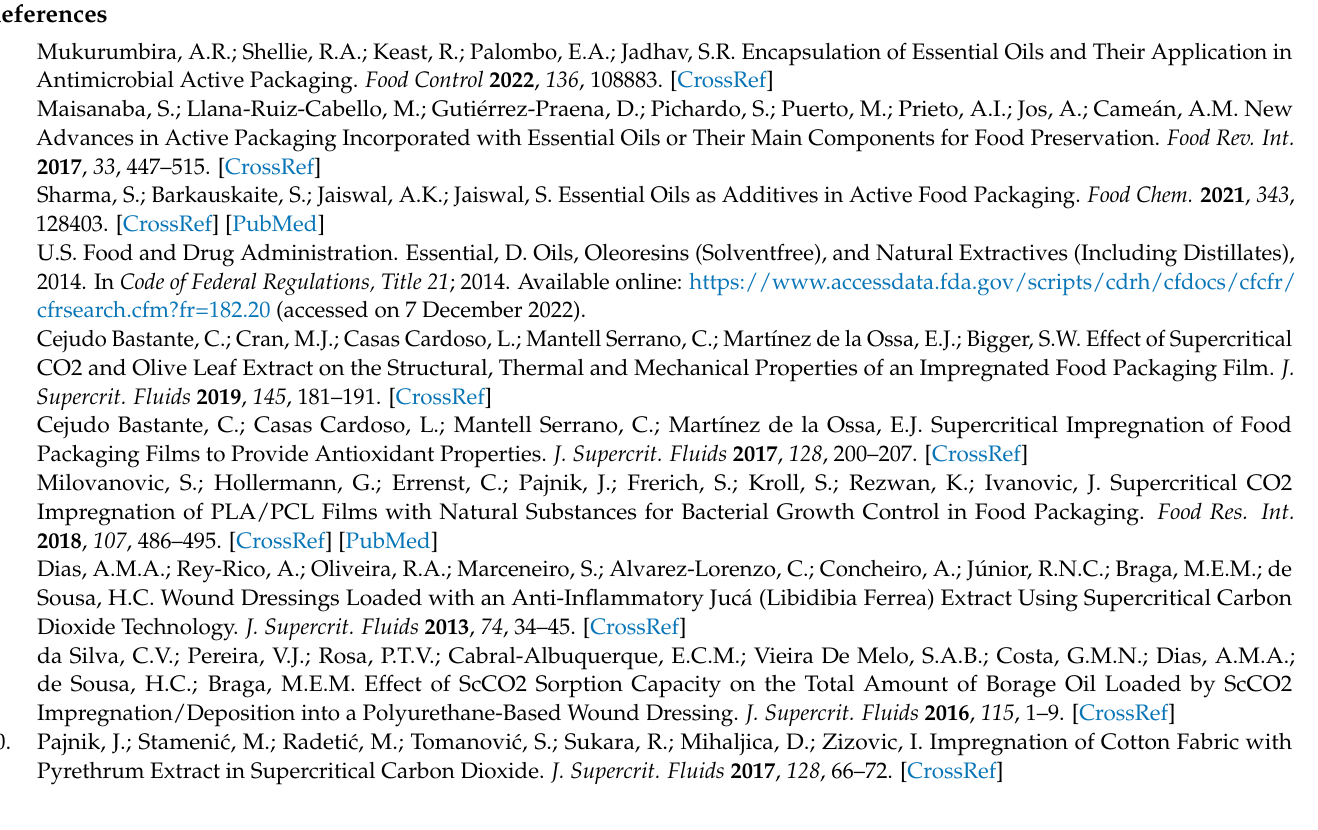
Table S1: Solubility of oil extract and of its four individual compounds in scCO 2 in conditions close to the one studied. Data reported from the literature. Table S2: FTIR peak assignments of clove extract, neat PC and impregnated PC. References [65,81–85,89] are cited in the supplementary